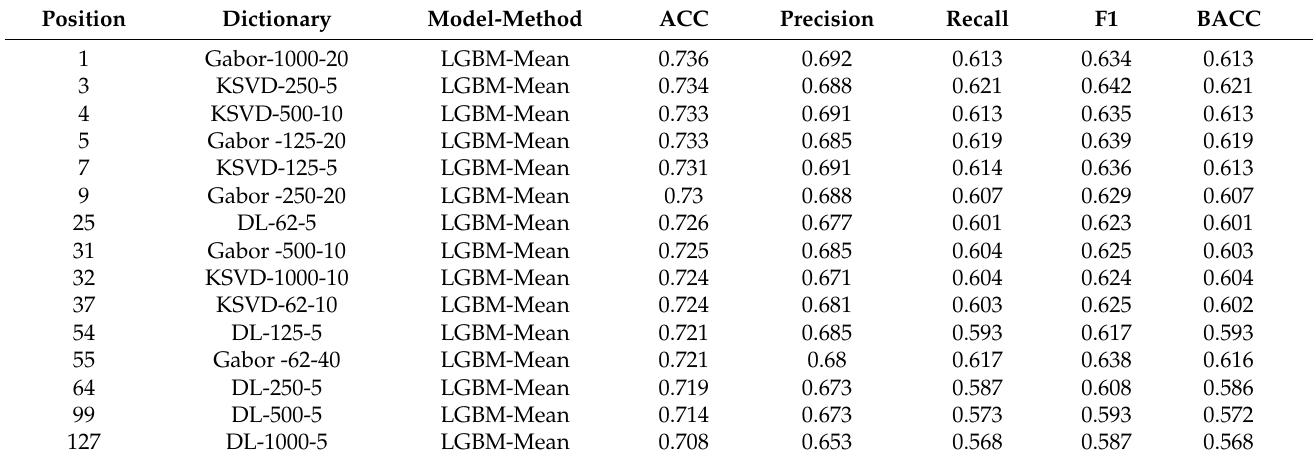
Table 1. Summary of average metrics scores for each dictionary, class size = 5.